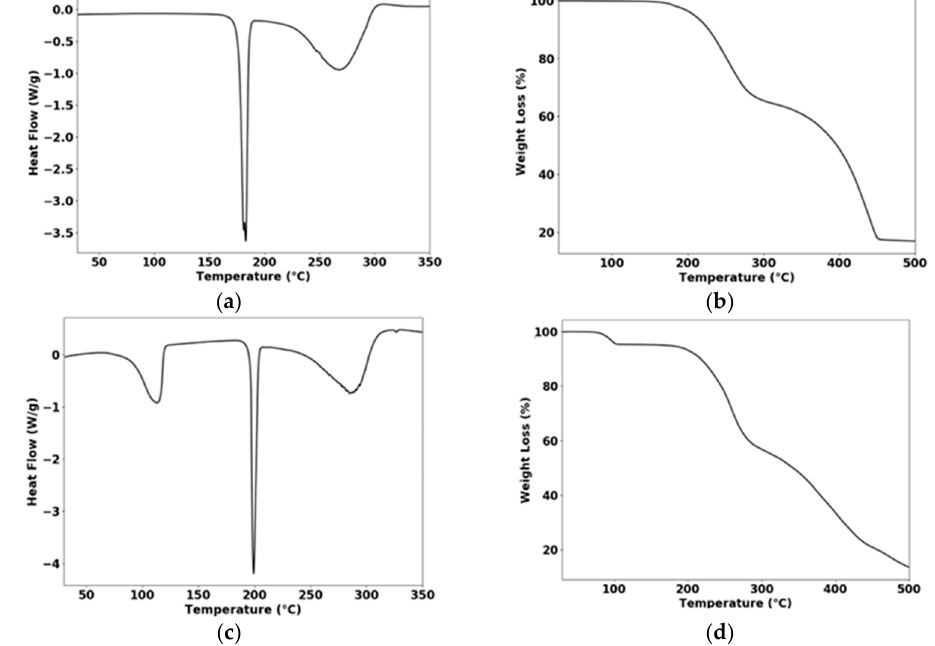
Figure 3. TGA and DSC thermograms of Zn(IBU) 2 (INC) 2 ( a , b ) and of Zn(IBU) 2 (INC) 2 (H 2 O) 2 ( c , d ).